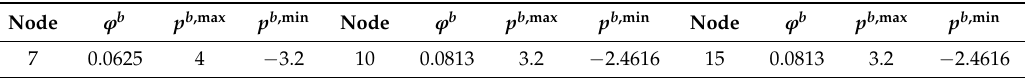
Table 4. Parameters associated with batteries and their initial